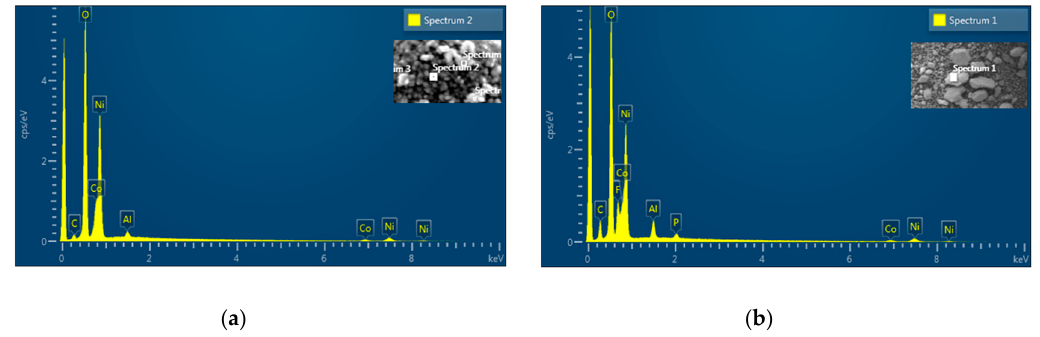
Figure 17. EDX spectroscopy of ( a ) pre-cycled NCAT4 and ( b ) post-cycled NCAT4. Table 5. Composition of pre-cycled and post-cycled NCAT4/NCAM2 sample.